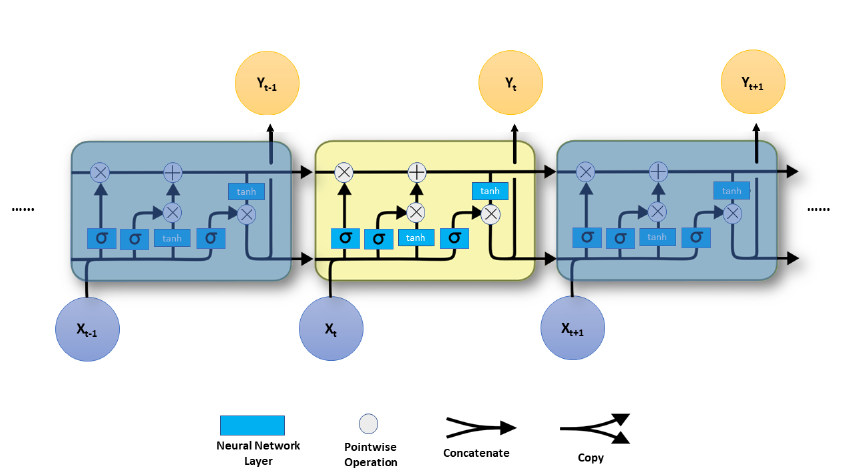
Figure 2. Long short-term memory